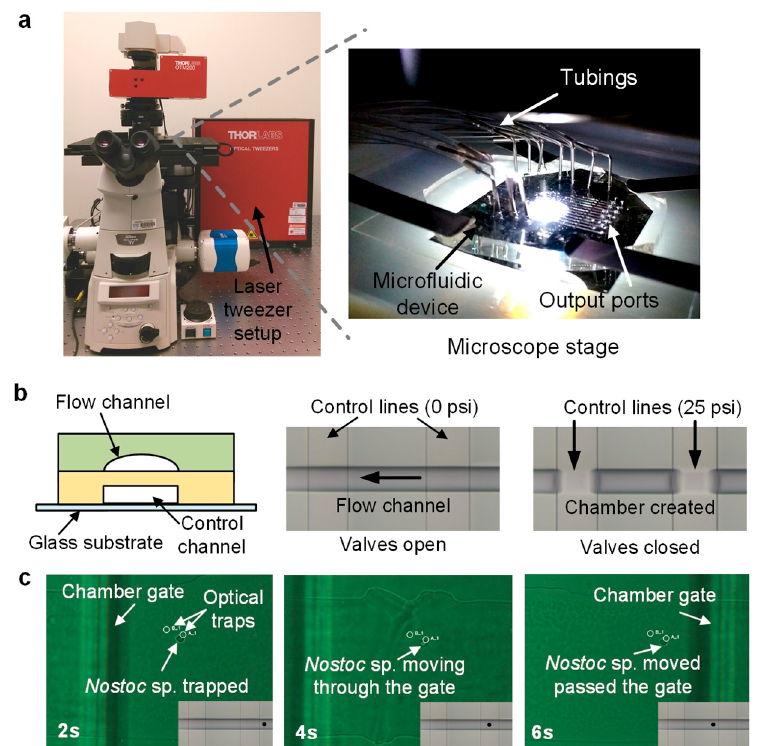
Figure 2. An overview of the optofluidic single-cell whole genome amplification (SC-WGA) platform. ( a ) This platform integrates an advanced microscope, optical tweezers, and a microfluidic device. The device consists of 12 parallel reaction systems. ( b ) The double-layer microfluidic device consists of flow channels in the top layer and control channels in the bottom layer. Chambers are formed by pressuring control channels into flow channels at their junctions. ( c ) Time-elapsed images of a single Nostoc sp. cell is trapped and moved into a chamber. The inset illustrates the location of the cell in the channel.